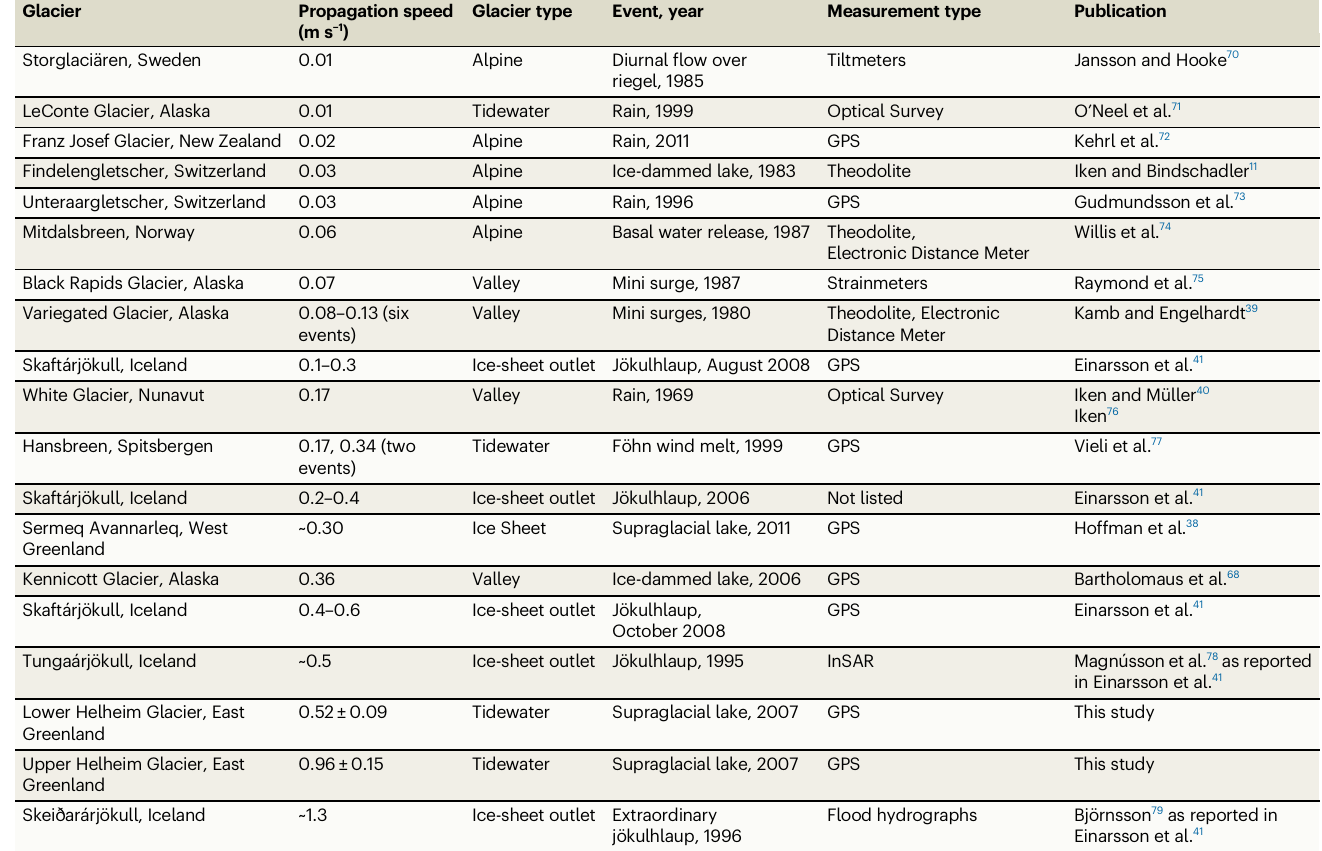
Table 1 | Previous observations of down-glacier fl ood propagation speeds following melt events, rain events, jökulhlaups, and lake